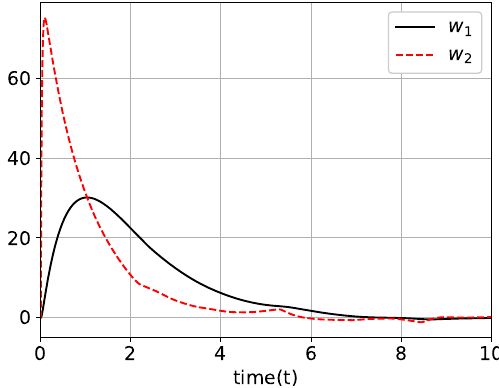
Figure 17. For HGO: trajectories of w 1 and w 2